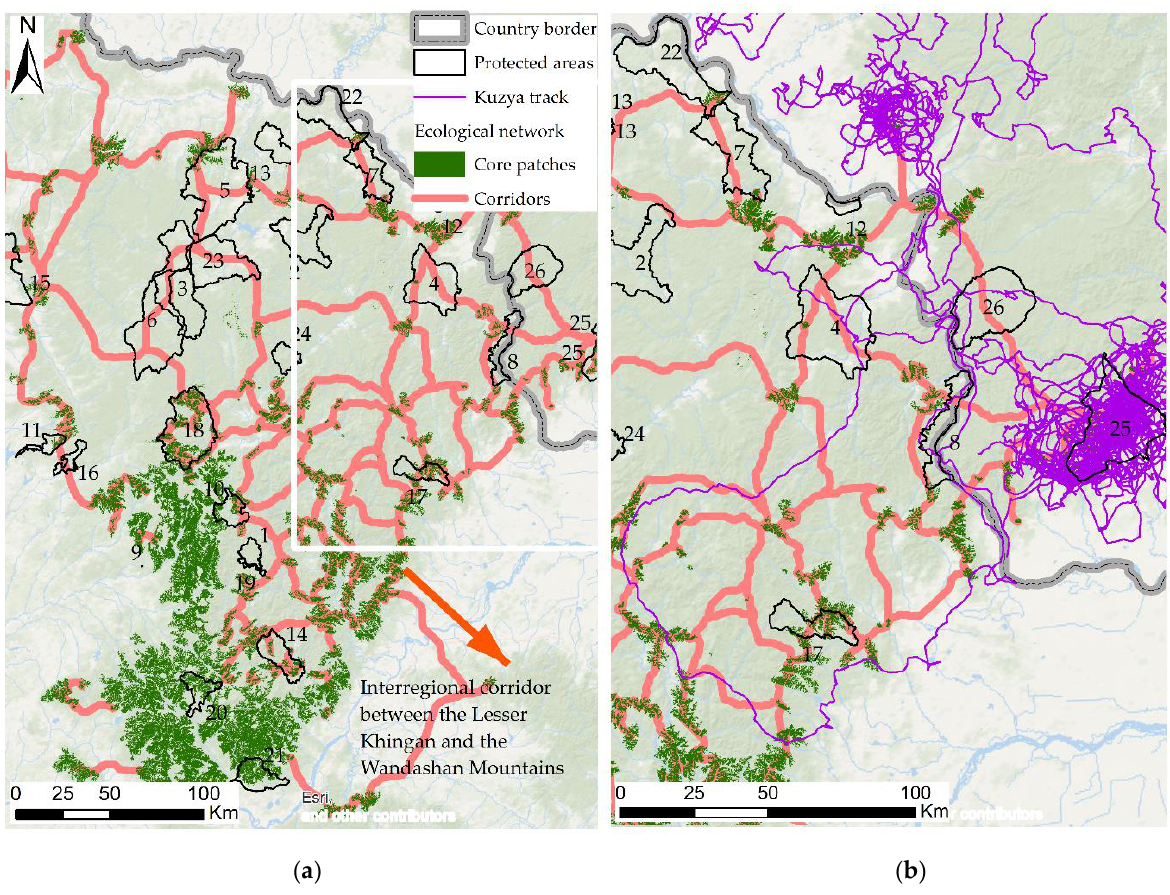
Figure 7. ( a ) Potential ecological network of the Lesser Khingan; ( b ) fragmentation of potential ecological network along the Amur River valley overlaid with track of tiger Kuzya [3].